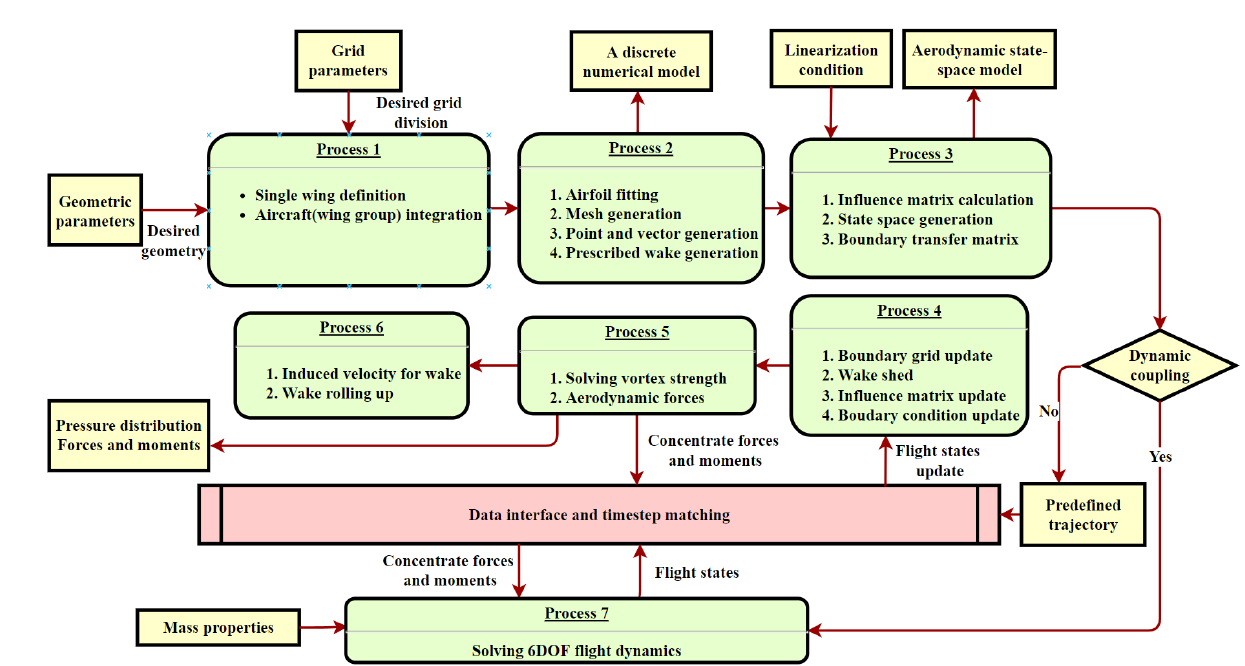
Figure 8. Time-stepping flow chart and data